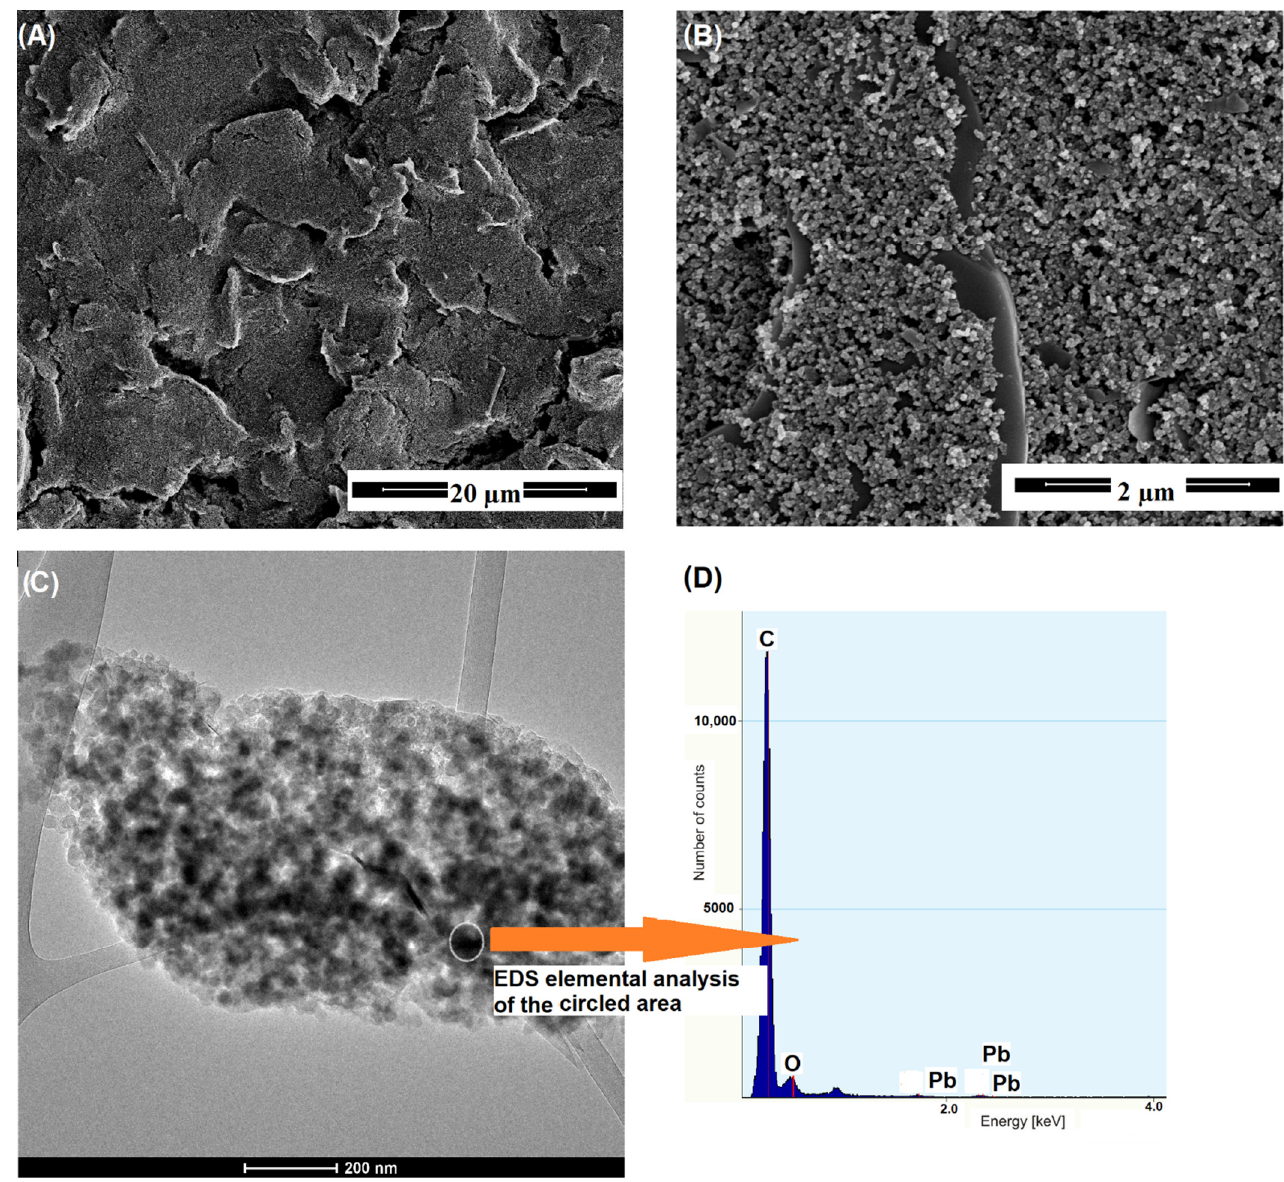
Figure 4. The SEM ( A , B ) and TEM ( C ) images of the pSPCE/PbNPs surface. ( D ) The EDS spectrum of the highlighted fragment of the pSPCE/PbNPs. The concentration of Pb(NO 3 ) 2 was 7.5 × 10 − 5 mol L − 1 .